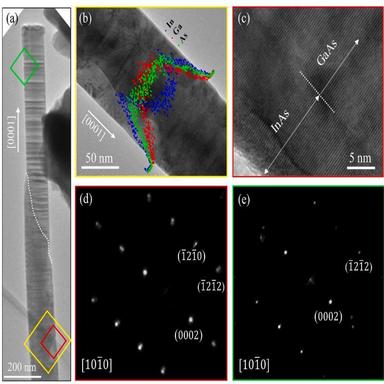
(a) TEM image of the top half of a GaAs/InAs NW, the topmost segment is not covered by InAs shell and distinguished from the covered part by a demarcation line, (b) higher magnification TEM image for segment of GaAs/InAs core/shell structure marked by yellow square, elemental compositions are scanned across the NW using EDS, (c, d) HR-TEM image and SAED pattern at GaAs/InAs interface of the area marked by red square, respectively, (e) SAED pattern of GaAs at the top area marked by green square.